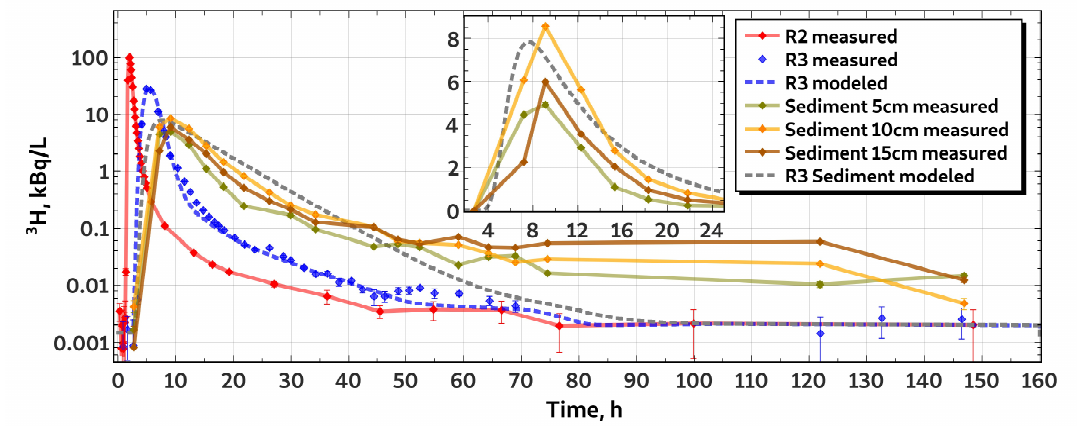
Figure 4. The 3 H activity concentrations observed at R2 and R3, and modeled at